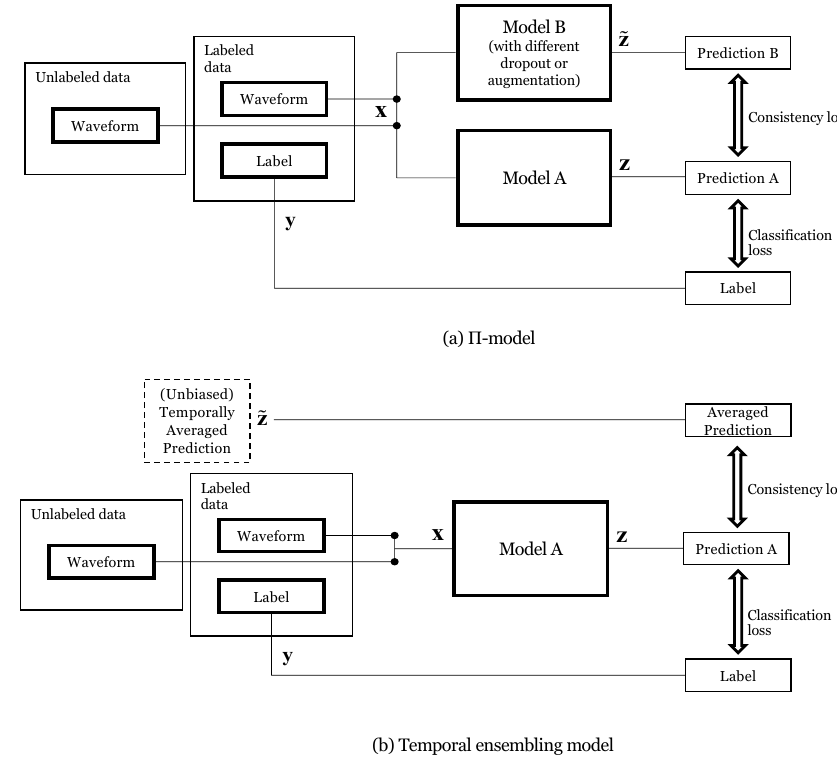
Figure 2. Schematic diagrams of consistency learning